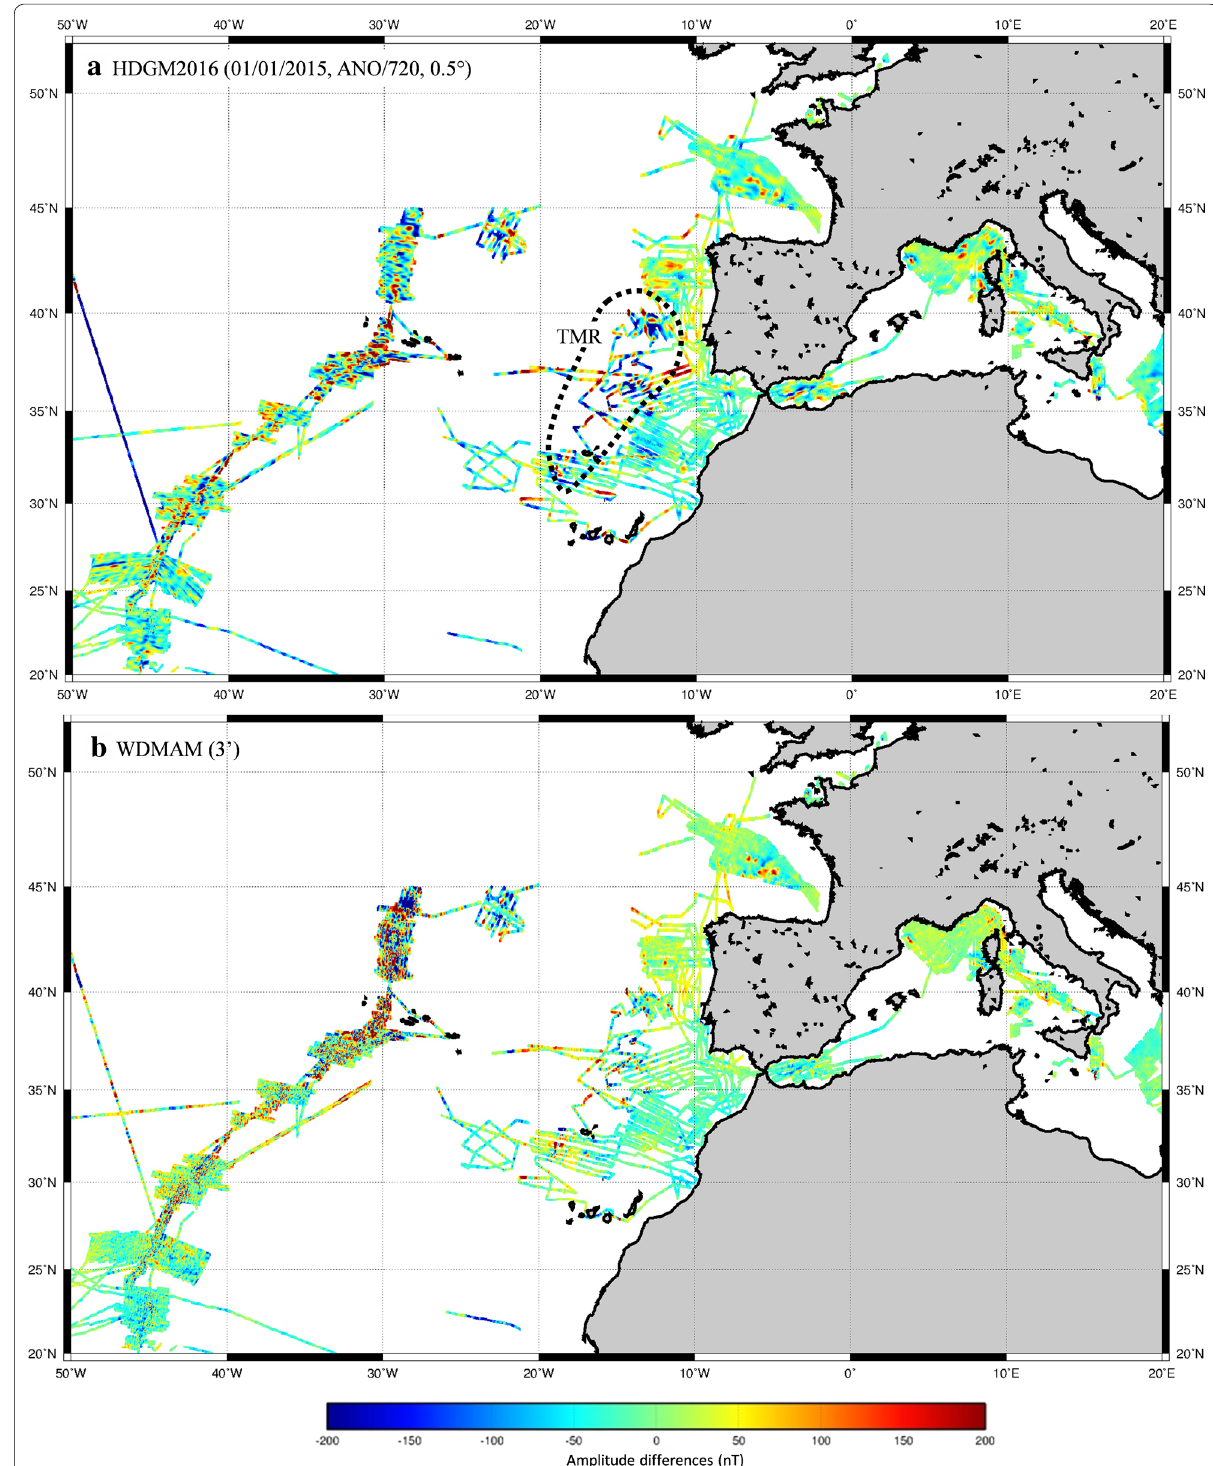
Fig. 8 Maps of differences between global anomaly models and marine data for the NEAWM area. a Intensity values of the anomaly field (ANO) estimated from HDGM2016 model up to SH degree 720 for the date 01/01/2015 (grid spacing: 0.5°) versus processed and filtered data. b WDMAM anomaly grid (grid spacing: 3 arc min.) versus unfiltered data. Images are derived from 2 min.‑gridded models of differences computed between models and data. TMR Tore‑Madeira